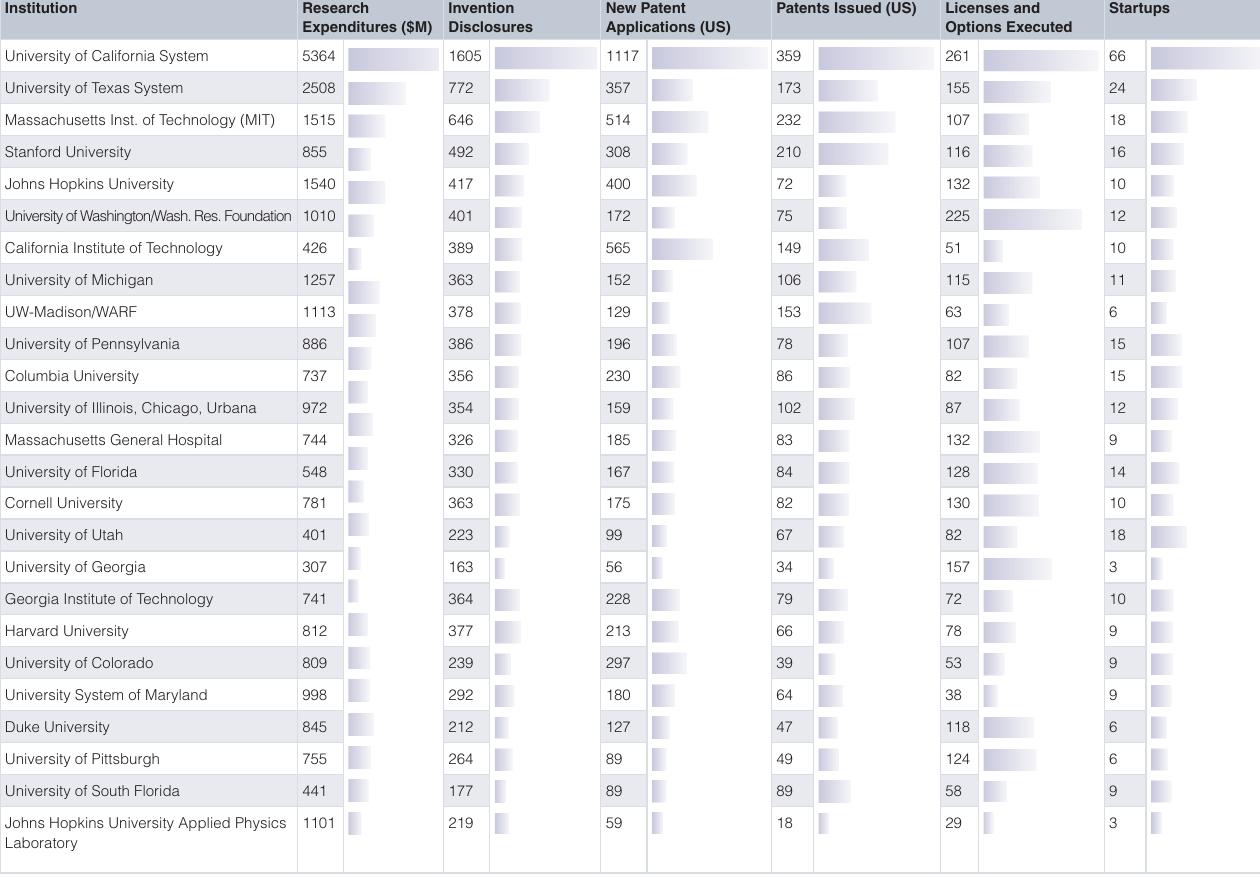
Table 1. The 25 top-performing institutions. Bar plots show the mean value over the years under consideration for each institution for each step in our commercialization pipeline. Institution Research Invention Expenditures ($M)